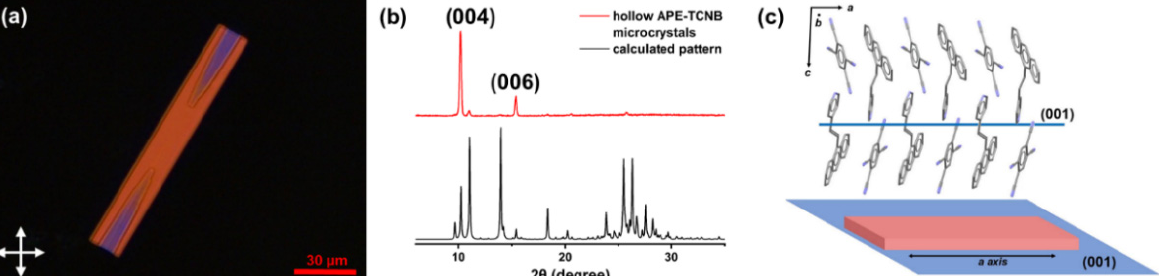
Figure 5. ( a ) The cross-polarized microscopy image of an APE-TCNB hollow cocrystal; ( b ) PXRD patterns of APE-TCNB (red) hollow cocrystals lying horizontally on the surface and the calculated PXRD pattern of APE-TCNB (black); ( c ) Molecule packing motif in the APE-TCNB cocrystals that are along the crystallographic a -axis.